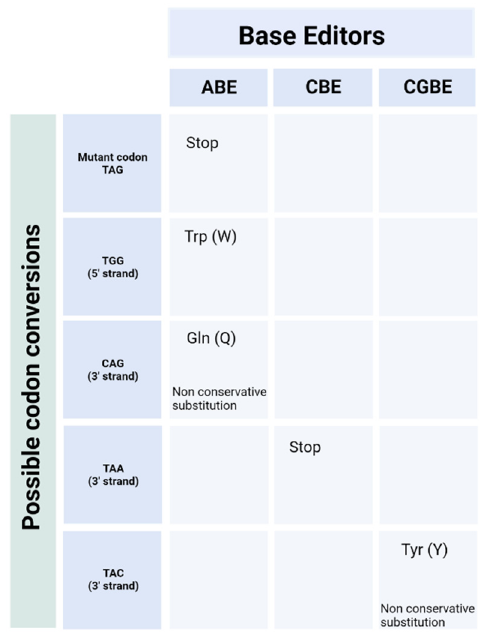
Figure 4. Amino acid conversions possible with base editing approaches to the c.11864G>A USH2A mutation. An adenine base editor can return the TAG stop codon back to the original TGG Typtophan codon. Adenine base editing of the A on the opposite strand of DNA or C to G base editing of the C on the opposite strand would enable read through, but results in non-conservative amino acid substitutions that could alter the structure of the protein (ABE) Adenine Base Editor, (CBE) cytidine base editor, (CGBE) C to G base editor Created with BioRender.com (accessed on 23 August 2022).